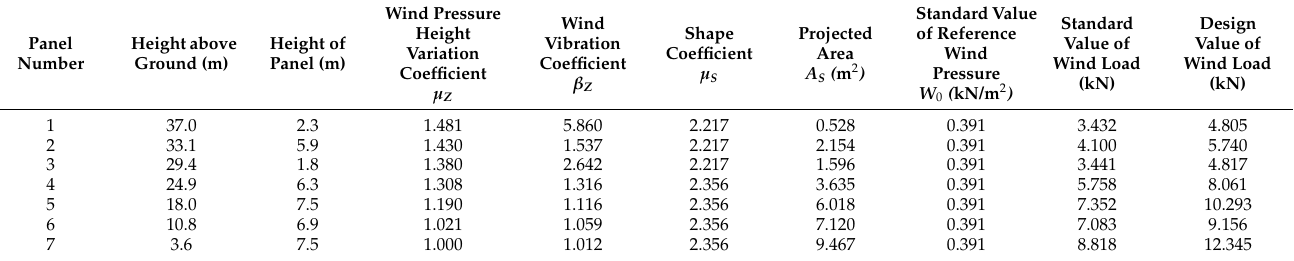
Table 3. Wind load of each panel (basic wind speed at 25 m/s, wind incidence angle at 90 ◦ ). Table 4. Wind load of conductor, ground line, and insulator.